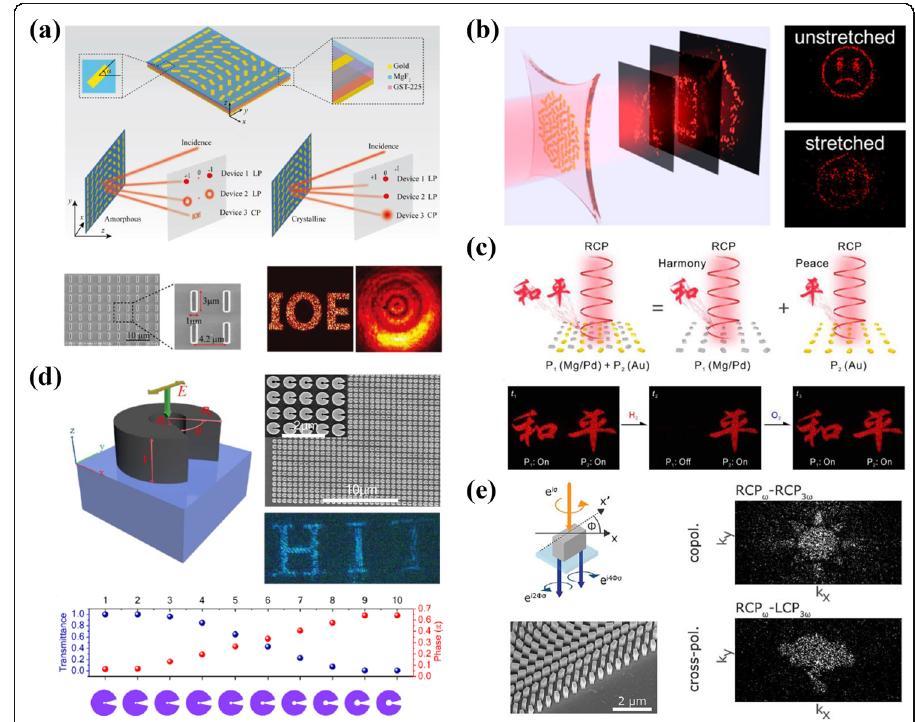
Fig. 7 Tunable metasurface holography and nonlinear metasurface holography. a Schematic of the demonstrated switchable photonic SOIs. Different optical performances of three designed metadevices can be switched when the GST layer is in amorphous or crystalline states. SEM images of fabricated patch antennas array are shown on the left bottom corner. The experimental results are shown on the right bottom corner [94]. b Schematic of a metasurface hologram on a stretchable substrate. The sizes and locations of holographic images can be changed by stretching the substrate [95]. c Merged metasurfaces composed of two independent phase profiles containing Mg/Pd and Au nanorods as dynamic and static pixels, respectively. The representative snapshots of the holographic images harmony and peace during hydrogenation and dehydrogenation are shown on the bottom [96]. d All-dielectric metasurfaces composed of C-shaped Si nanoantennas for nonlinear holography at THG [100]. e Silicon metasurfaces for nonlinear wavefront control of the third-harmonic generation and multiplexed holography. The generated nonlinear signal acquires phase modulations of θ co = 2 σϕ and θ cross = 4 σϕ in co- and cross-polarization states controlled by the oreientation angle, respectively. The experimental results of multiplexed holography are shown on the right